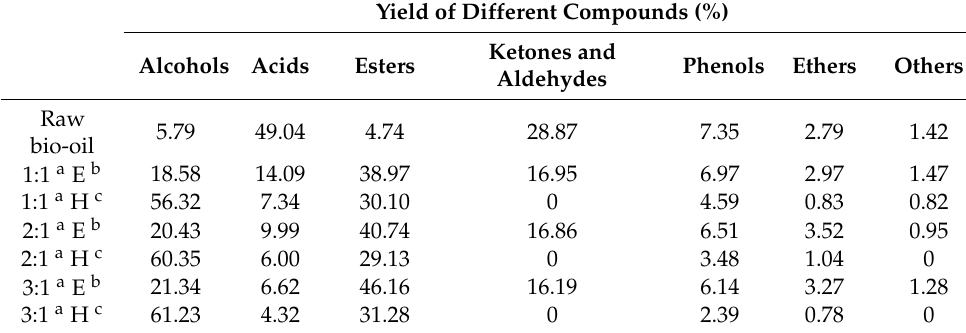
Table 3. The distribution of the liquid products after esterification and catalytic hydrogenation with different alcohol oil